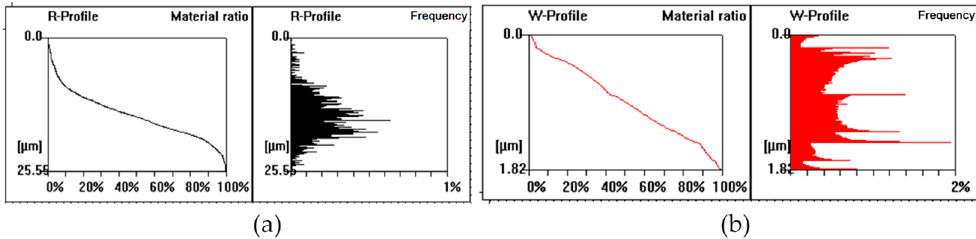
Figure 12. The material ratio curves and frequency density curves for the profiles measured in parallel direction to the wire feed: ( a )—for the roughness, ( b )—for the waviness.